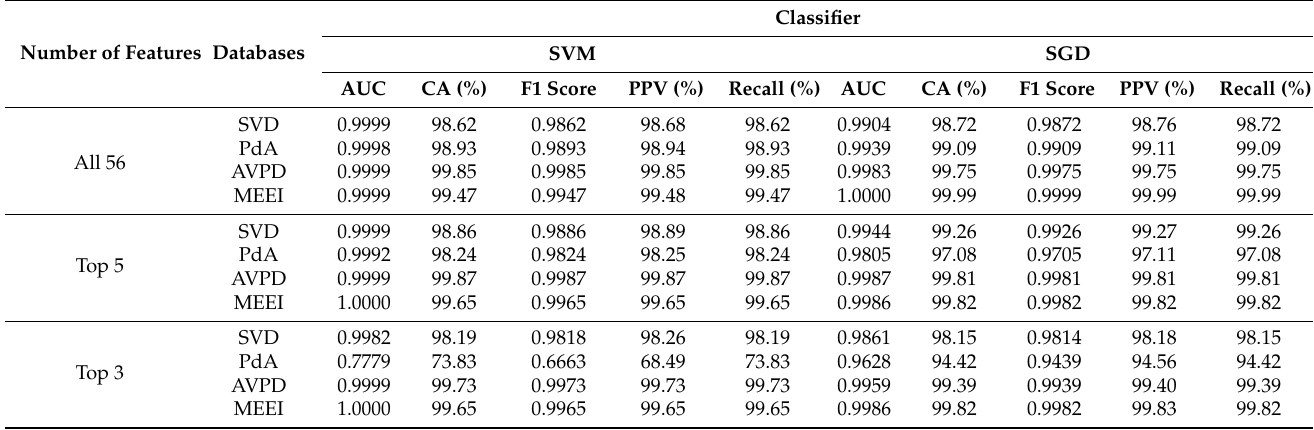
Table 5. Performance indicators for SVM and SGD classifiers for multiclass.